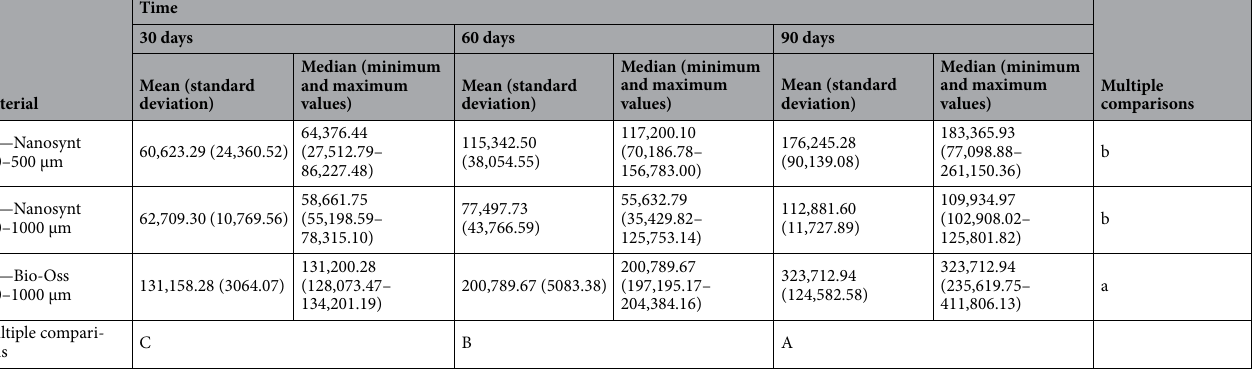
Table 3. Mean (standard deviation), median (minimum and maximum values) of bone neoformation area (μm 2 ) as a function of materials and time. Distinct letters (vertical case and horizontal capital)